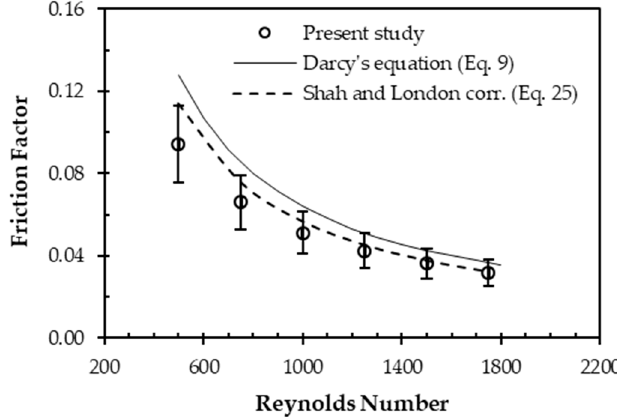
Figure 3. Validation of the friction factor compared to the well-known correlation.